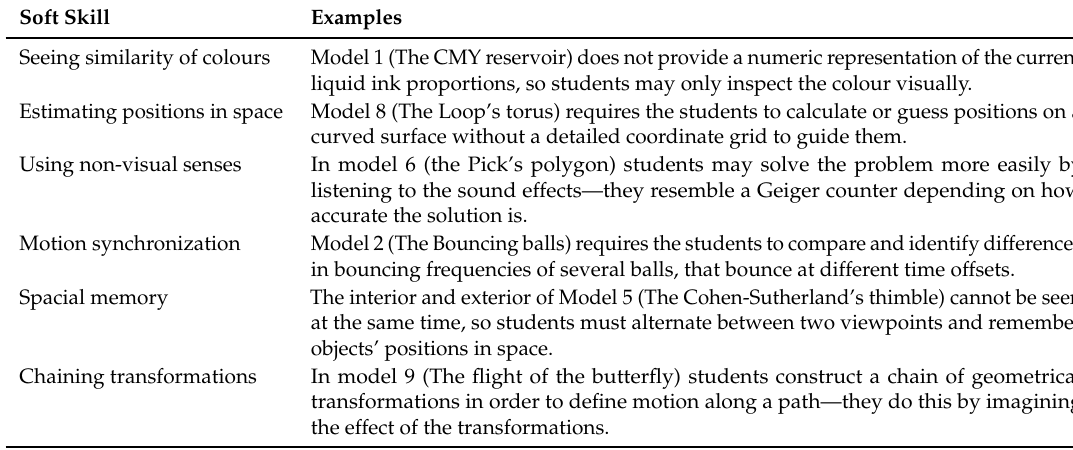
Table 5. Some soft skills and their support in the